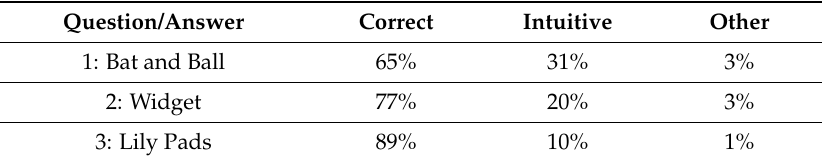
Table A8. Distribution of Answers on the CRT for Men Alone.